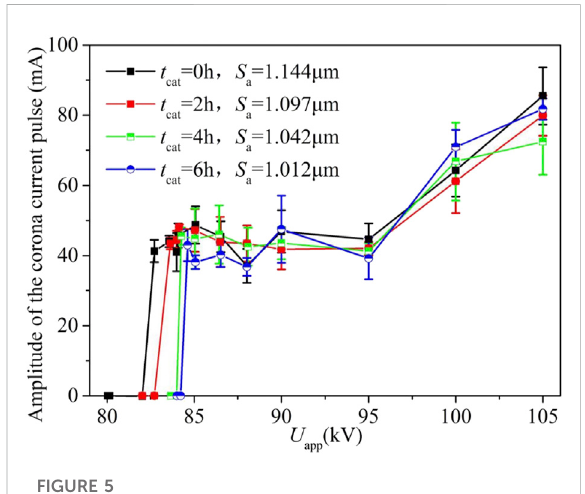
FIGURE 5 The amplitude of corona current pulse of corona current measurement results (Xu et al.,